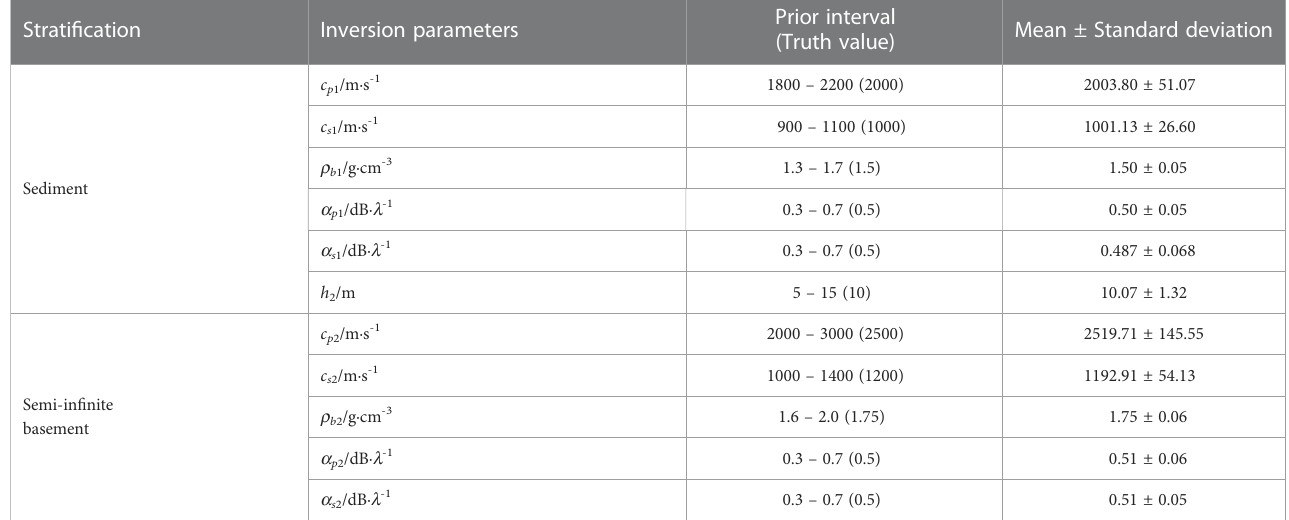
TABLE 1 Inversion results of seabed parameters in the simulation